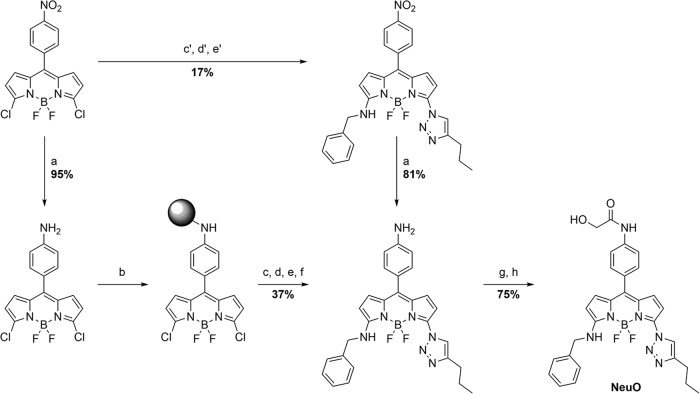
Synthesis of NeuO: conditions. Solid-phase method: (a) 1 M HCl-activated Fe, AcOH/EtOH (1:10), 5 minutes; (b) CTC-PS resin, DIEA, CH2Cl2/DMF, rt, 24 hours; (c) NaN3 (9 Eq), DMF, rt, 30 minutes; (d) benzylamine (10 Eq), DIEA/DMF (1:4), rt, 45 minutes; (e) 1-pentyne (10 Eq), CuI (4 Eq), l-AscA (4 Eq), rt, 30 minutes; (f) 0.5% TFA in CH2Cl2, 10 min; (g) (AcO)CH2COCl, saturated NaHCO3, CH2Cl2, 30 minutes; and (h) K2CO3, MeOH:H2O (10:1), 2 hours. Solution-phase alternative: (c′) NaN3 (10 Eq), MeOH:THF (2:1), rt, 5 h; (d′) benzylamine (2 Eq), 1 hour; and (e′) 1-pentyne (3 Eq), Cu(ACN)4PF6, TBTA, THF, rt, 120 hours. AcOH, acetic acid; CTC, chlorotrityl chloride; DIEA, diisopropylethylamine; DMF, dimethylformamide; PS, polystyrene; rt, room temperature; TFA, trifluoroacetic acid.